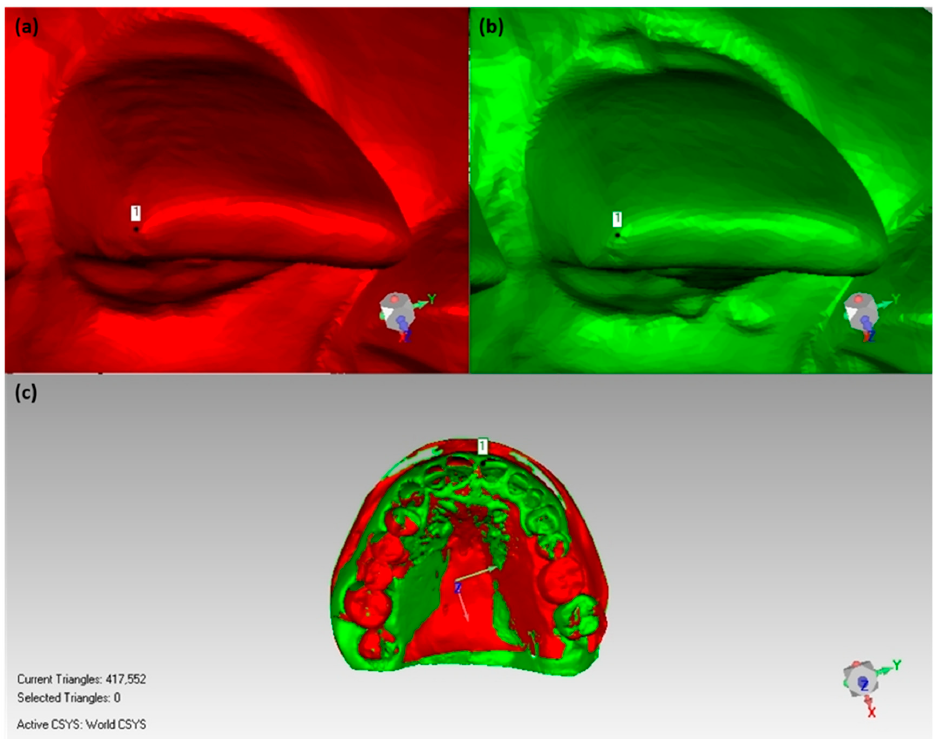
Figure 2. Matching and superimposition of preoperative and postoperative models for soft tissue volume calculation. The preoperative ( a ) and postoperative ( b ) cast scanned images were superimposed ( c ) by fixed reference points: the buccal surfaces of the central incisors and the distal surfaces of the most posterior teeth.